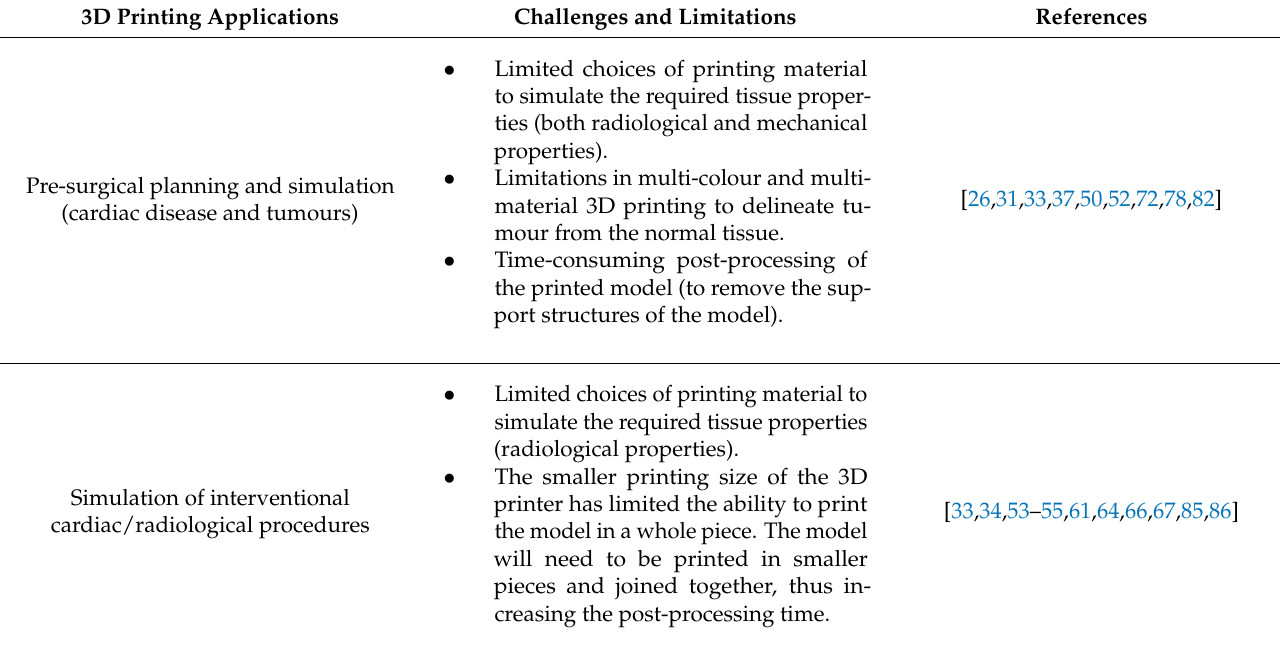
Table 4. Limitations and challenges of 3D printing for medical